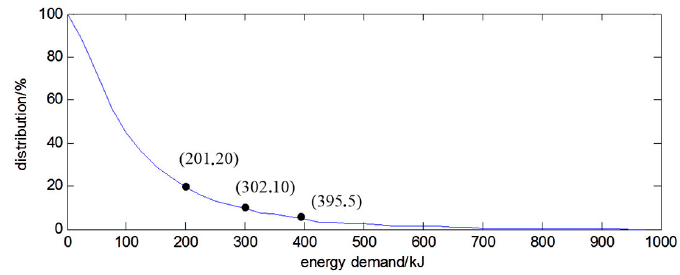
Figure 5. The distribution rate of demand energy value in discharge condition.